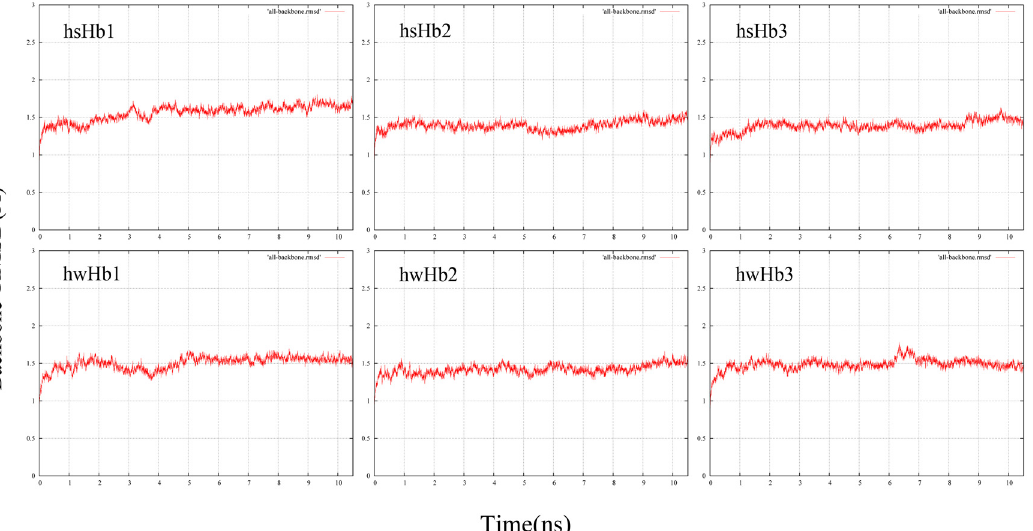
Fig 4. Evolution of root mean square deviation (RMSD) of the atoms in the backbone of the proteins over time from the initial structure for: P . przewalskii (hsHb1, hsHb2, hsHb3) and P . erythrurus (hwHb1, hwHb2, hwHb3).